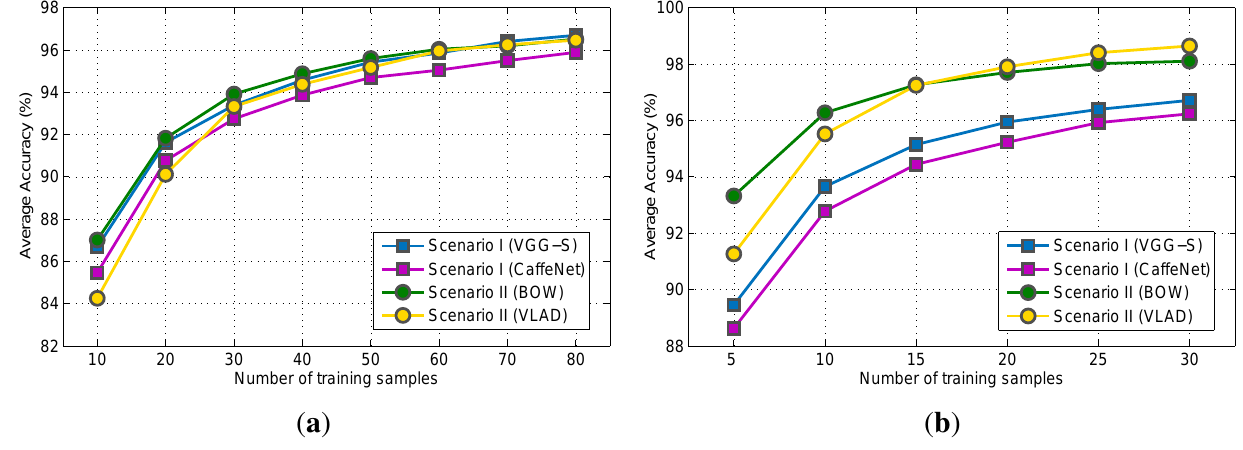
Figure 9. Performance on two datasets with a varying number of training samples.